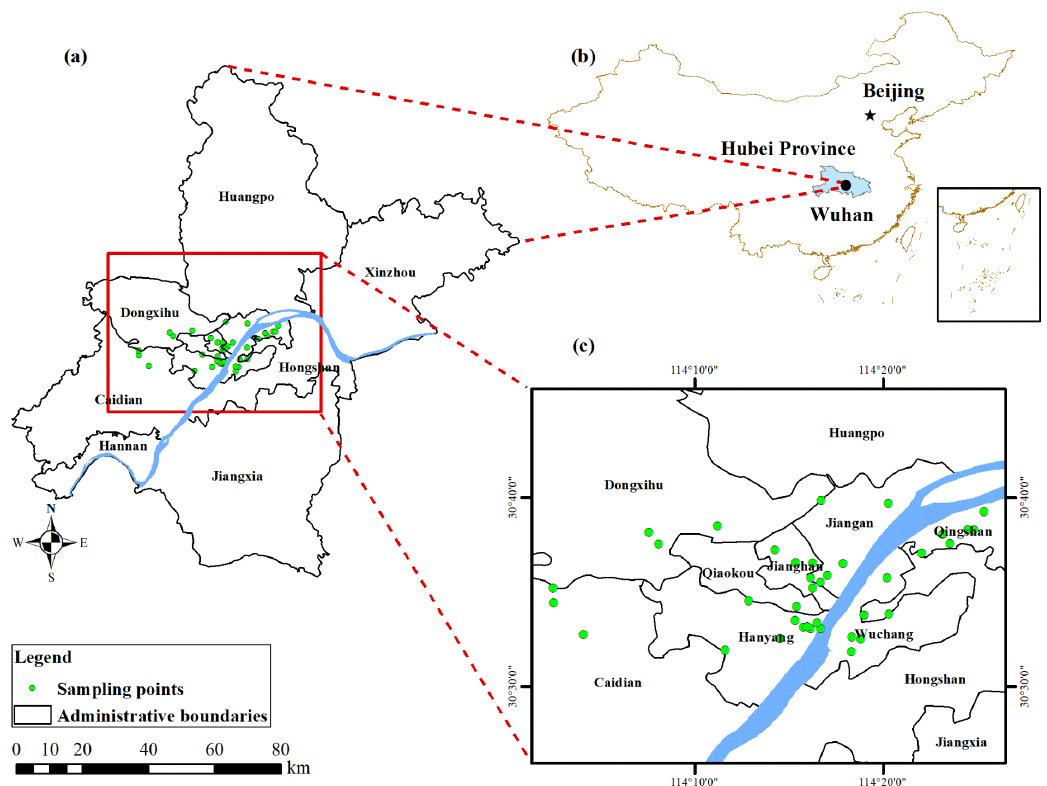
Figure 1. Geographical location of the soil sampling sites ( a ). China’s border, ( b ). Urban area, ( c ). Specific sampling point.